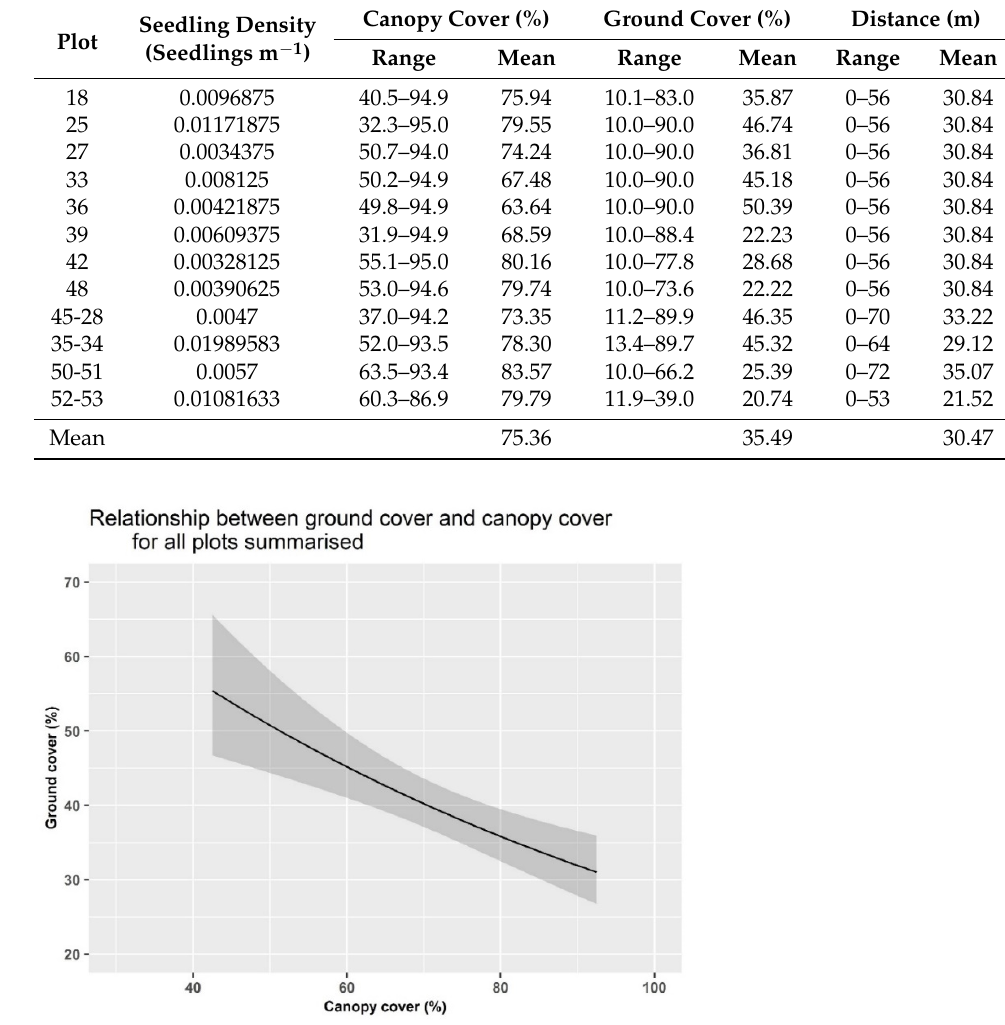
Table 2. Summary of the means and ranges of the covariates in 12 plots. In the case of plots with two seed trees, the plot name is a combination of the two tree numbers.